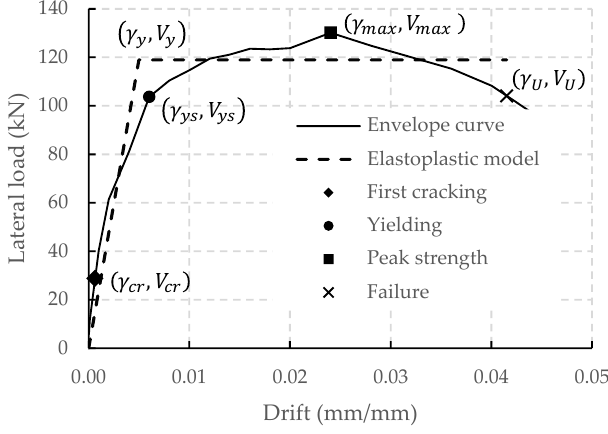
Figure 10. Envelope curve and critical points.